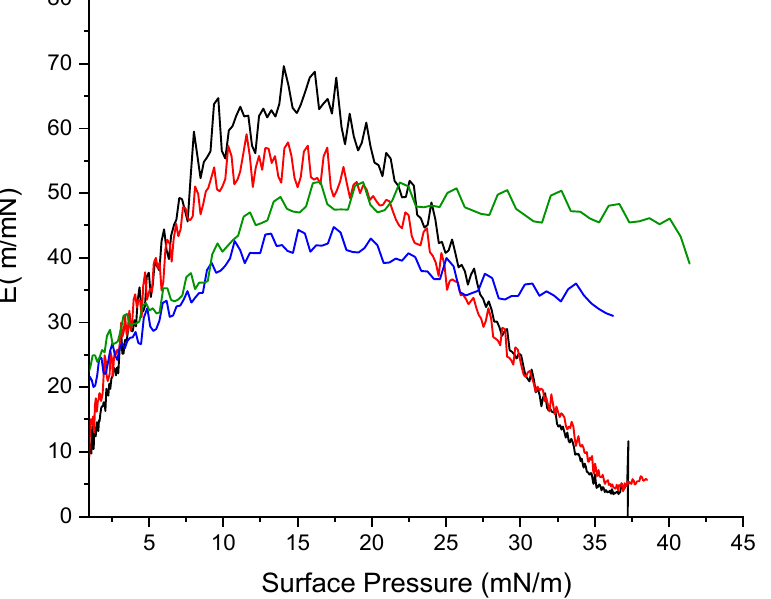
Figure 14. Elastic modulus as a function of surface pressure. Zein (red line), C 3 (LA) 2 (blue line), C 6 (LA) 2 (green line) and C 9 (LA) 2 (black line).